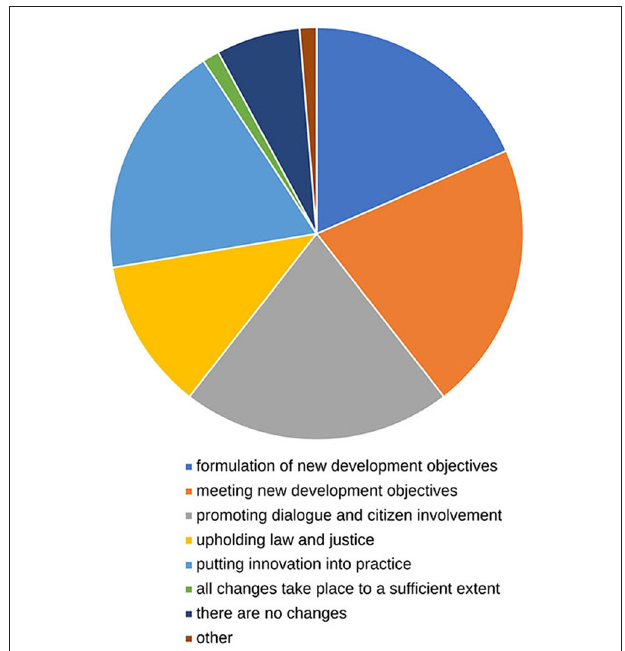
FIGURE 2 | Categories of changes that are NOT taking place in the field of sustainability, n = 46. Answers to the multiple-choice question “Tick which changes to sustainability in your LAG are NOT happening on a sufficient scale, and list the actors that YOU would need to help kick-start them”